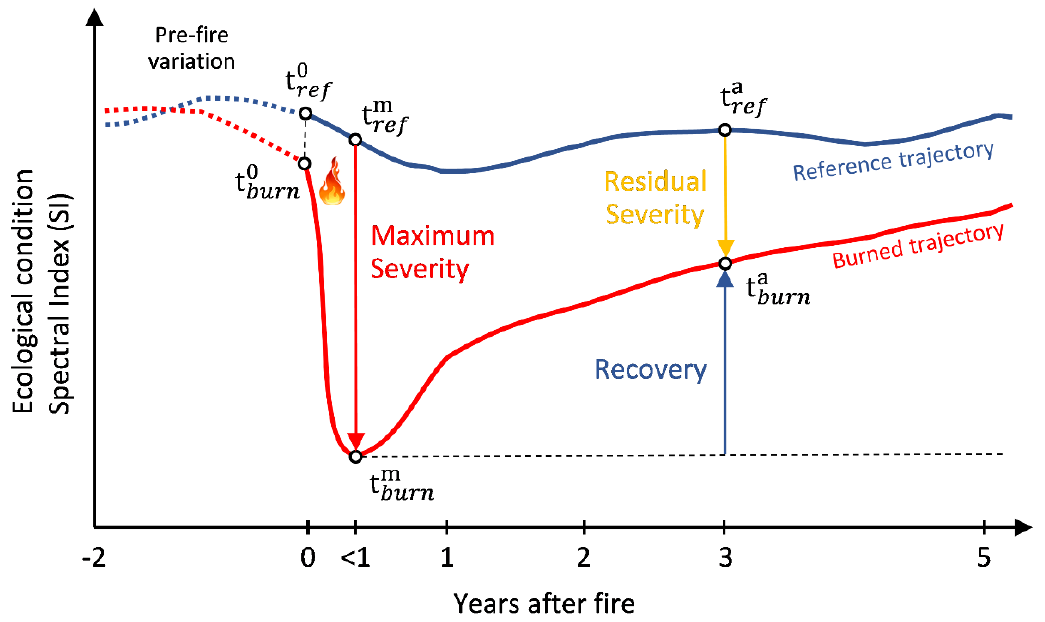
Figure 2. Temporal trajectories of burned and unburned vegetation. This conceptual model represents the effect of fire on vegetation as well as severity and recovery patterns. Spectral Indices serve as proxies to represent the ecological condition of the vegetation. Modified and adapted from Key [65] and Chompuchan Lin and Chompuchan & Lin [64].